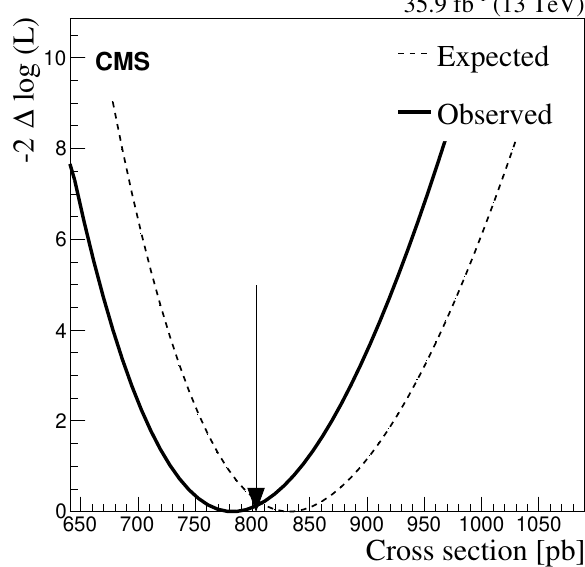
Figure 4. The expected and observed dependence of the likelihood on the total tt cross section (cid:27) . It is derived from the (cid:12)ducial phase space by a simple extrapolation. The arrow points at the tt cross section measured in the light dilepton (cid:12)nal state. The goodness of the (cid:12)t determined with a Kolmogorov-Smirnov method yields a p value of